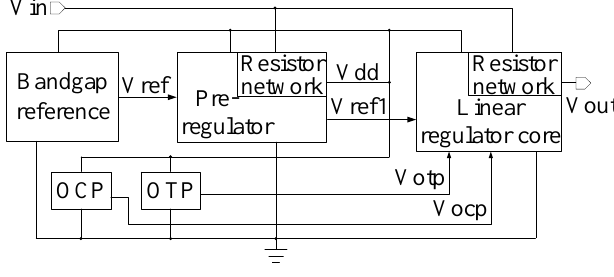
Figure 1. The configuration of the proposed design.